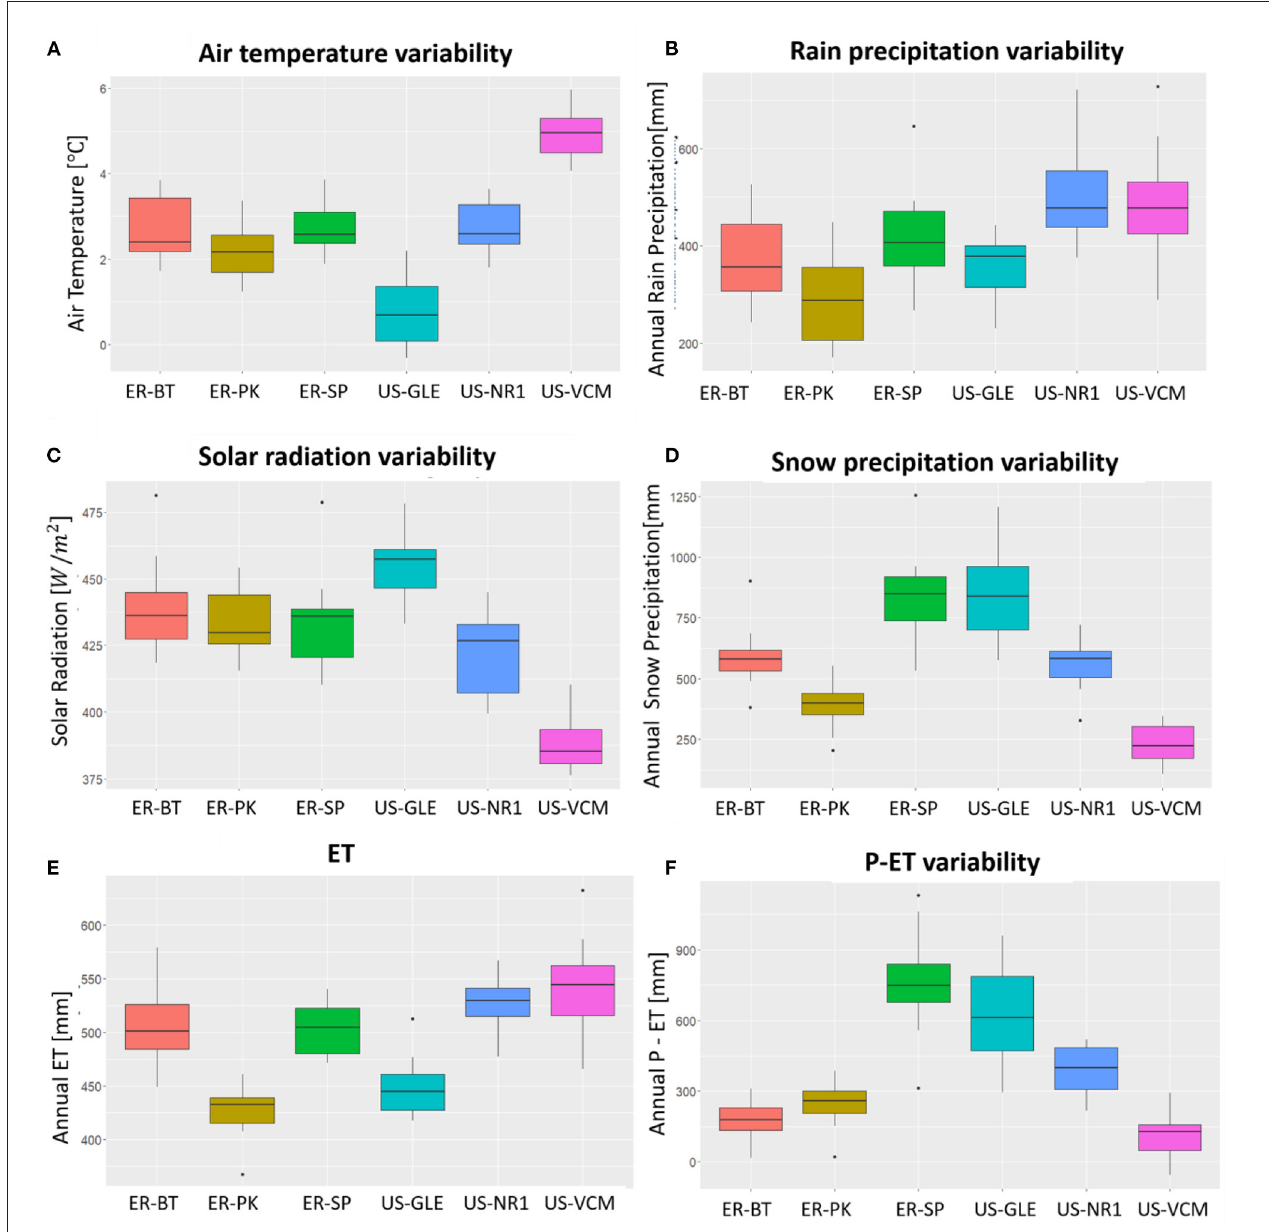
FIGURE 4 | Spatial variability in attributes air temperature (A) , rain precipitation (B) , solar radiation (C) , and snow precipitation (D) as well as ET (E) and P-ET (F) across the six